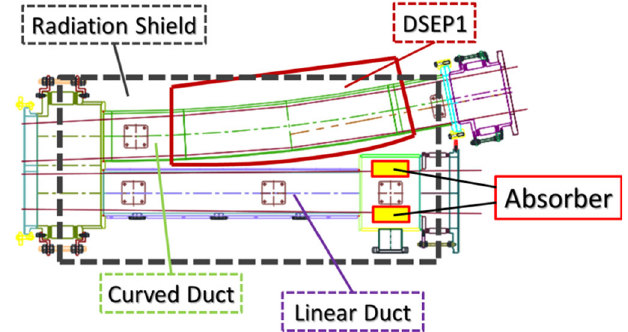
FIG. 4. Construction of the H 0 collimation system.